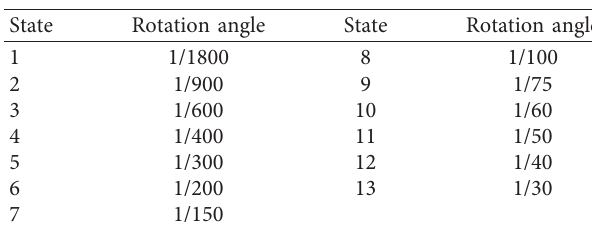
Figure 12: Drainage system. (a) Drainage holes. (b) Permeable stone. Table 3: The selected rotation angle for